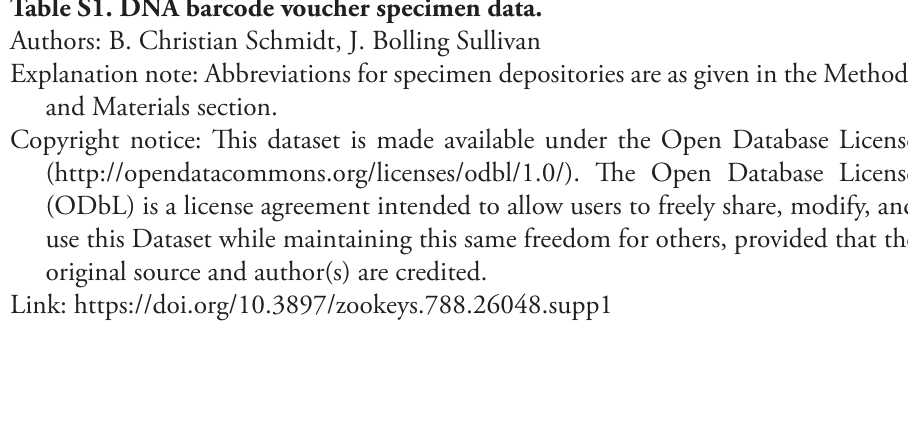
Table S1. DNA barcode voucher specimen